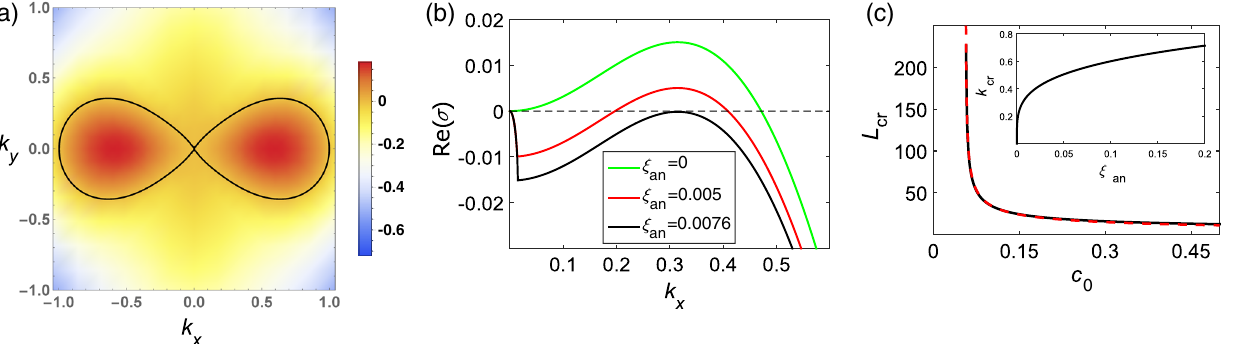
¼ 0 . Maximum an values, c 0 ¼ 0 . 2 . (c) Critical p ffiffiffiffiffiffiffiffiffiffiffiffiffi an ∼ 1 = c − c . Inset: k vs ξ , from Eq. cr cr cr an